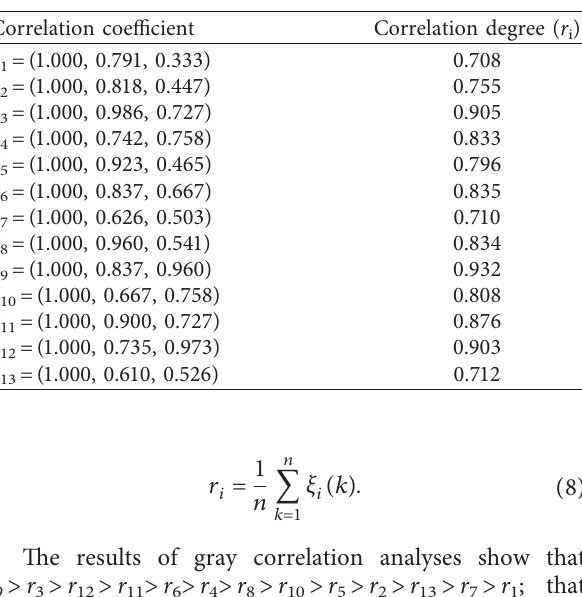
Table 9: Correlation degree of gray correlation